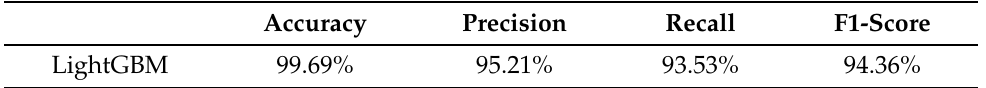
Table 3. Evaluating the indicators of